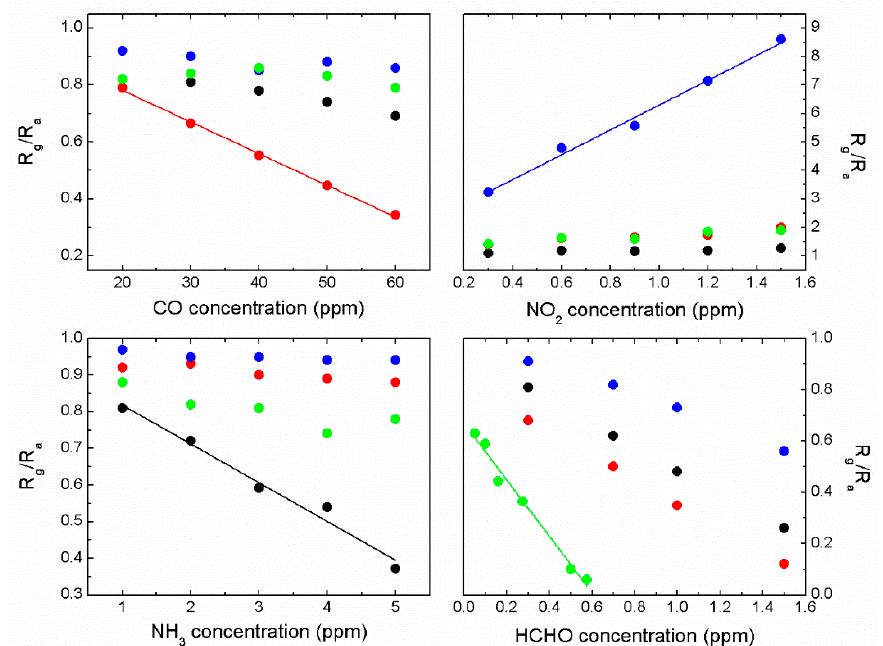
Figure 5. Calibration of the SN (SnO 2 with 1 wt % Pd), IN, WO (WO 3 with 1 wt % Ru), and SZ (SnO 2 -ZnO with 1 wt % Pd) sensors for monitoring CO, NO 2 , NH 3 , and HCHO. Note that black, red, blue, and green solid circles represent WO, SN, IN, and SZ, respectively.